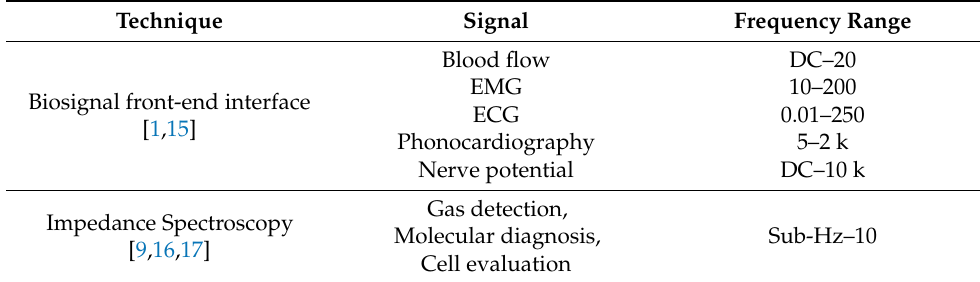
Figure 1. Block diagram of ( a ) general-purpose front-end sensor interface, and ( b ) dual-phase FRA-based electrochemical impedance spectroscopy (FRA-EIS). Table 1. Review of signals and their range of operation.